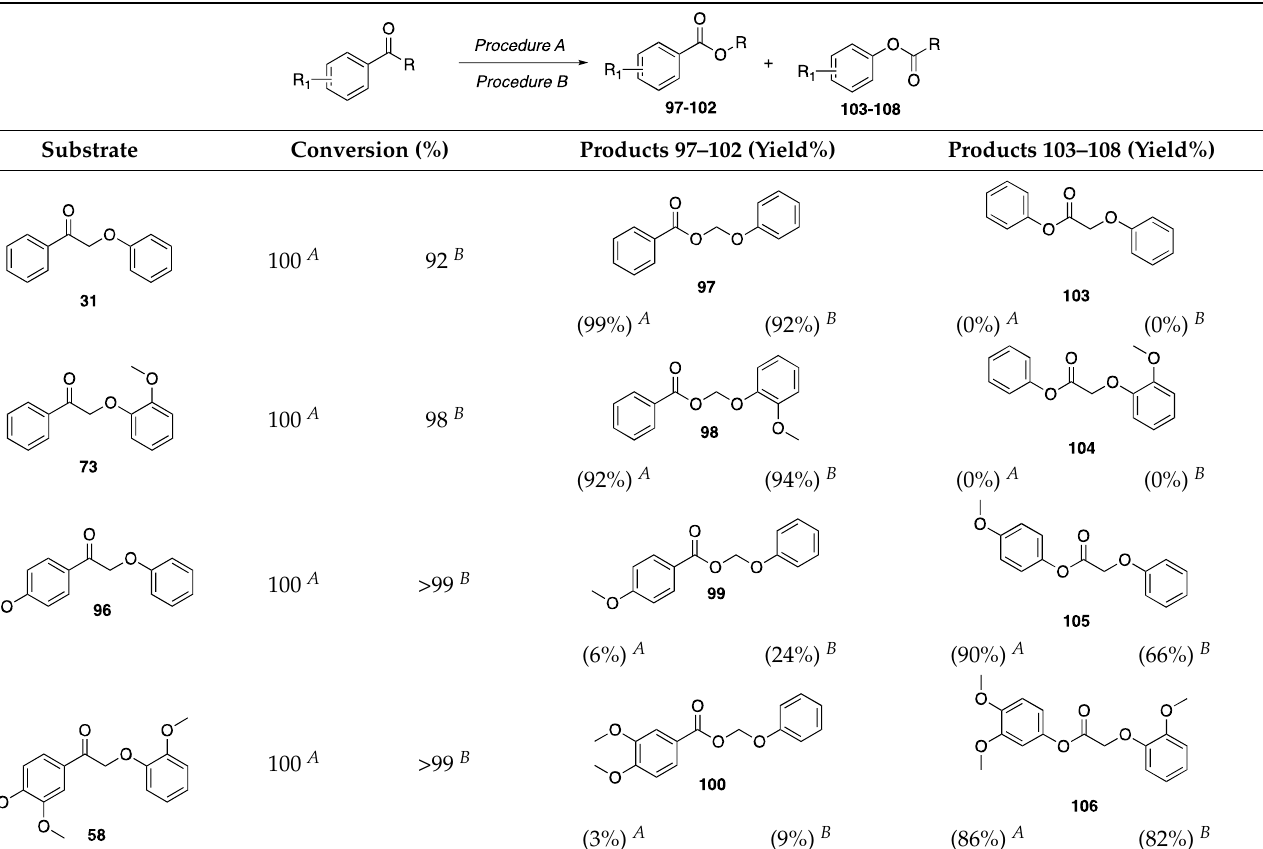
Table 5. BV oxidation of lignin model compounds.